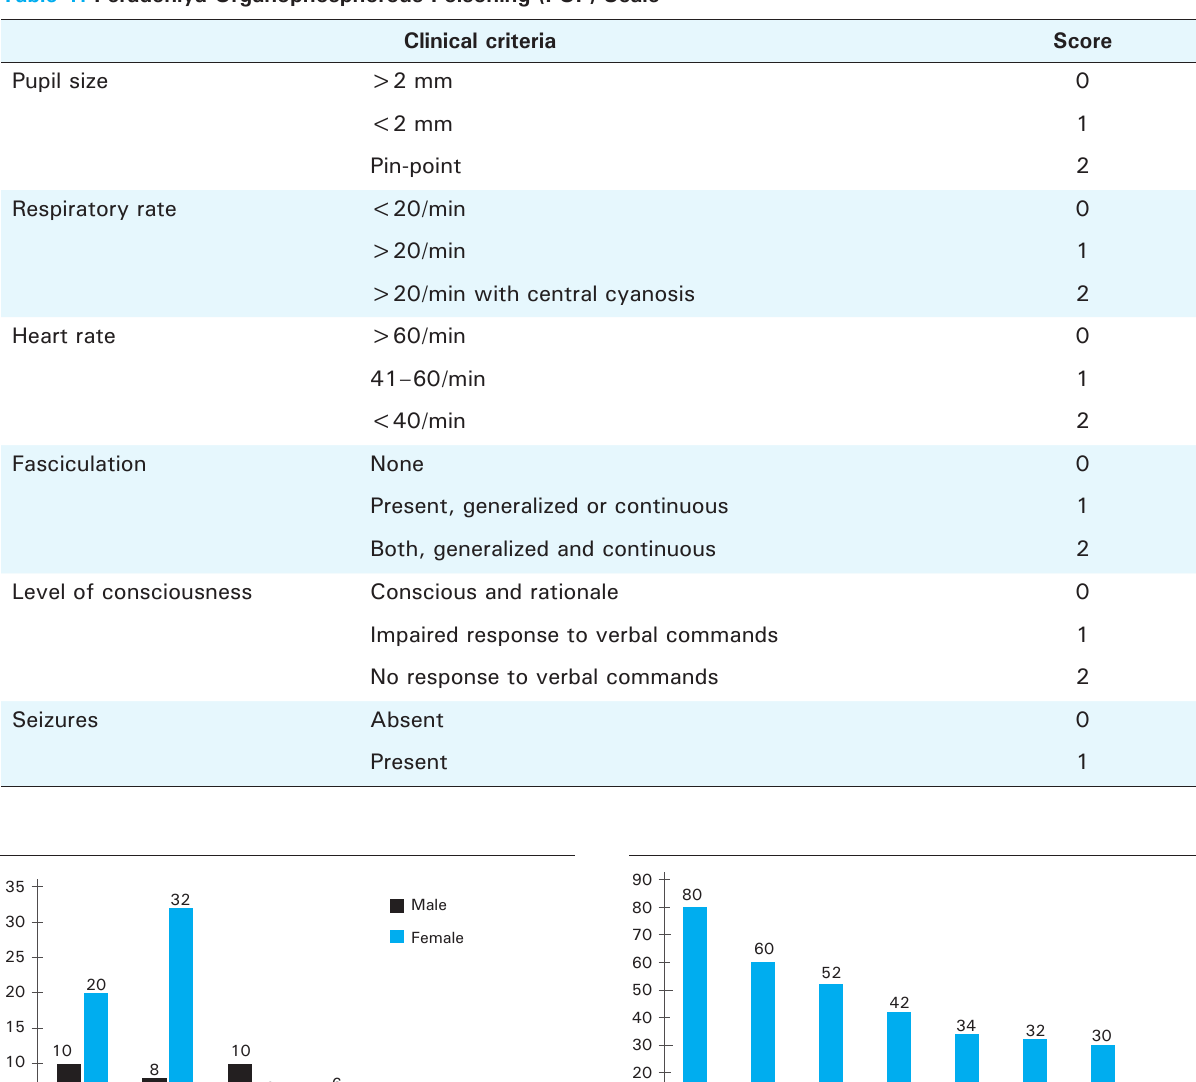
table 1. Peradeniya organophosphorous Poisoning (PoP) scale 14